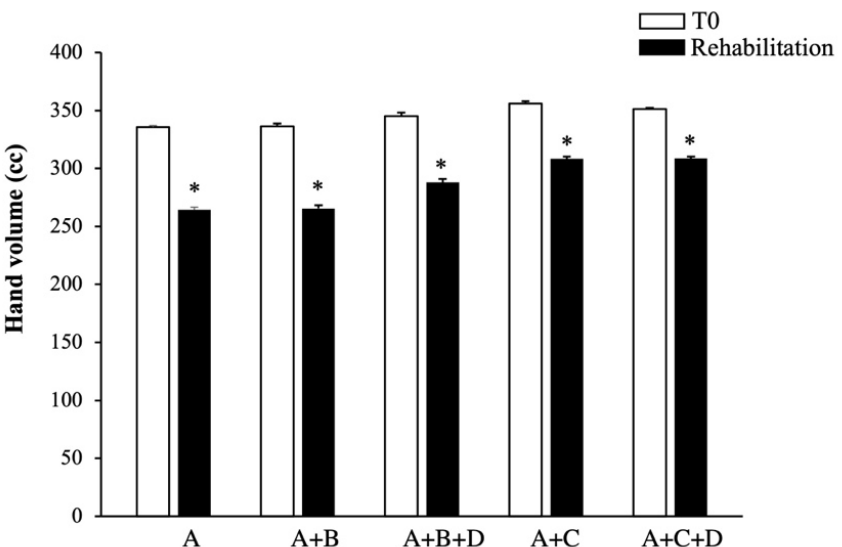
Figure 9. Amount of volumetric edema measured by a hand volumeter before (T0) and after (T1) the different rehabilitation paths. * p ≤ 0.05 compared with T0.